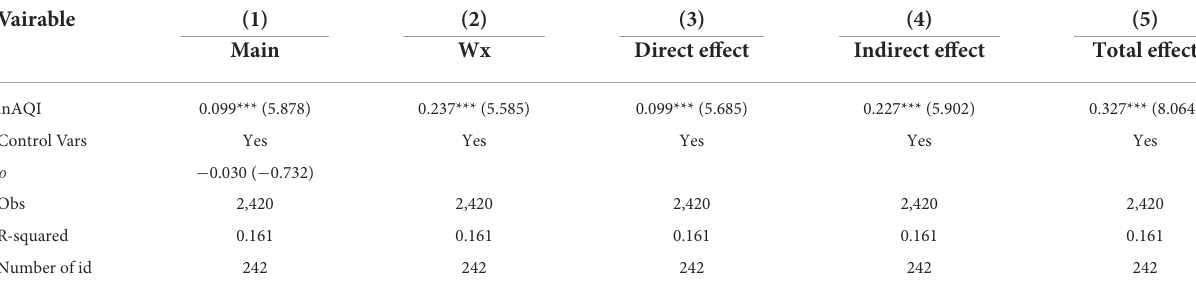
TABLE 11 Impact of air quality improvement on enterprise productivity—weight matrix of economic distance.